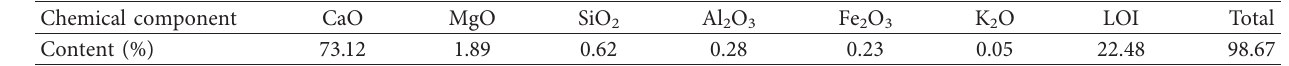
Table 3: Major chemical components of the used lime.